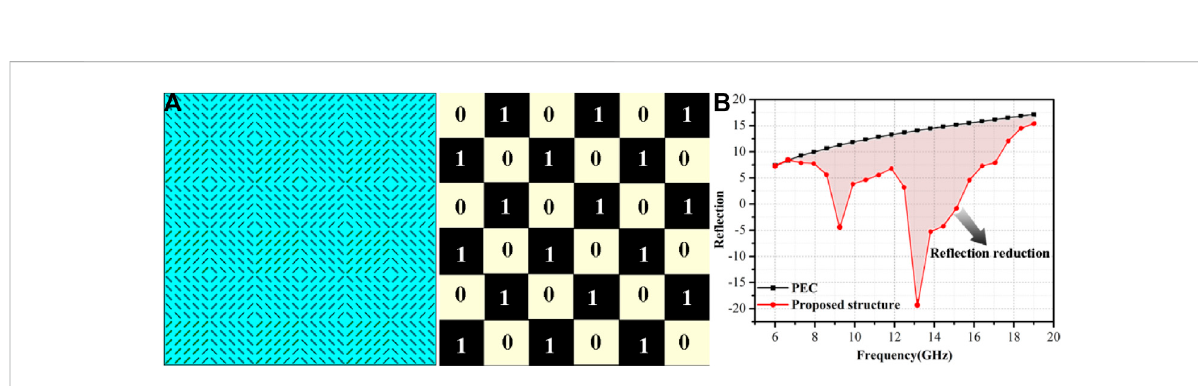
FIGURE 8 (A) Chessboard structure consisting of 6*6 sub-elements; (B) simulated re fl ection spectra of the PEC and RCS for the chessboard structure.